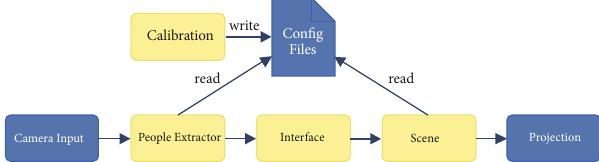
Figure 2: The high-level architecture of the